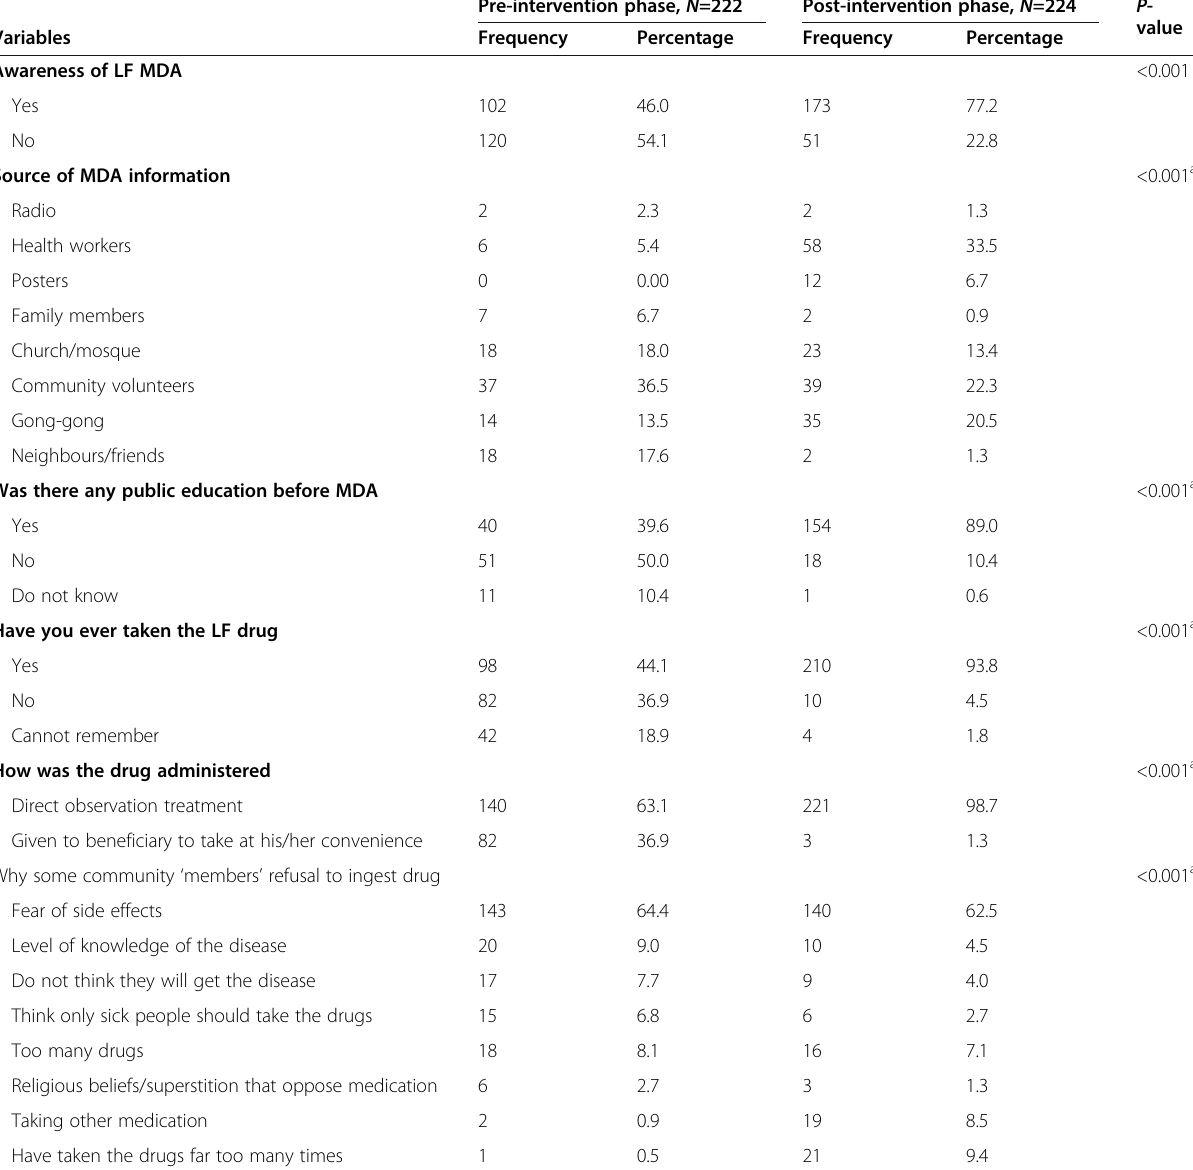
Table 4 Knowledge of lymphatic filariasis mass drug administration in pre- and post-intervention among community members in Bole District Pre-intervention phase, N =222 Post-intervention phase, N =224